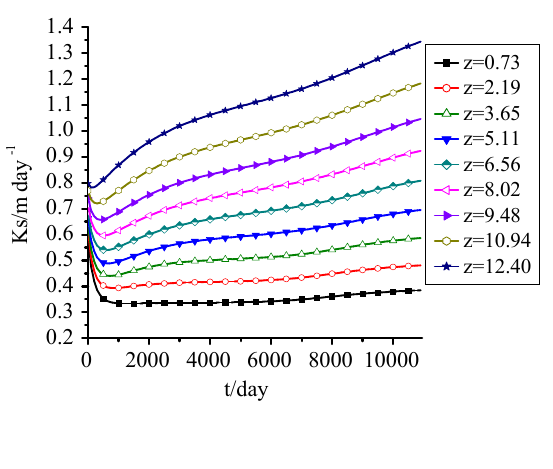
Figure 4. Ks change with